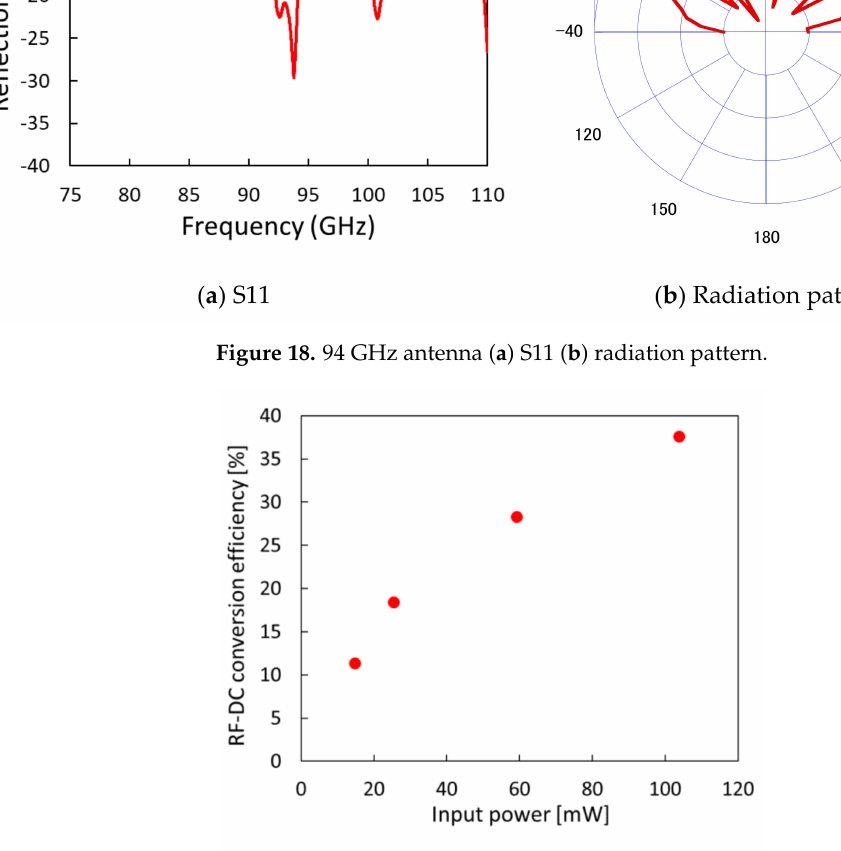
Figure 19. 94 GHz rectifier RF–DC conversion